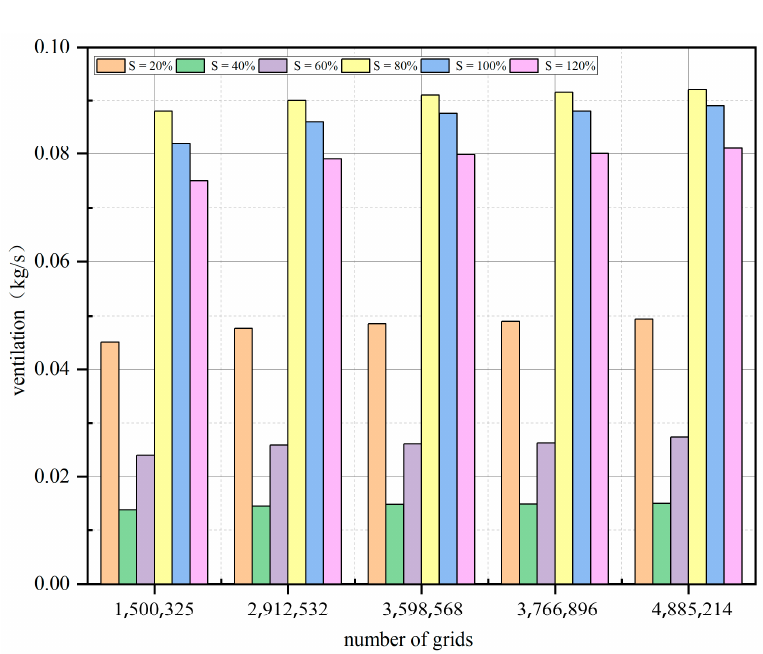
Figure 4. Calculated ventilation under different numbers of grids.